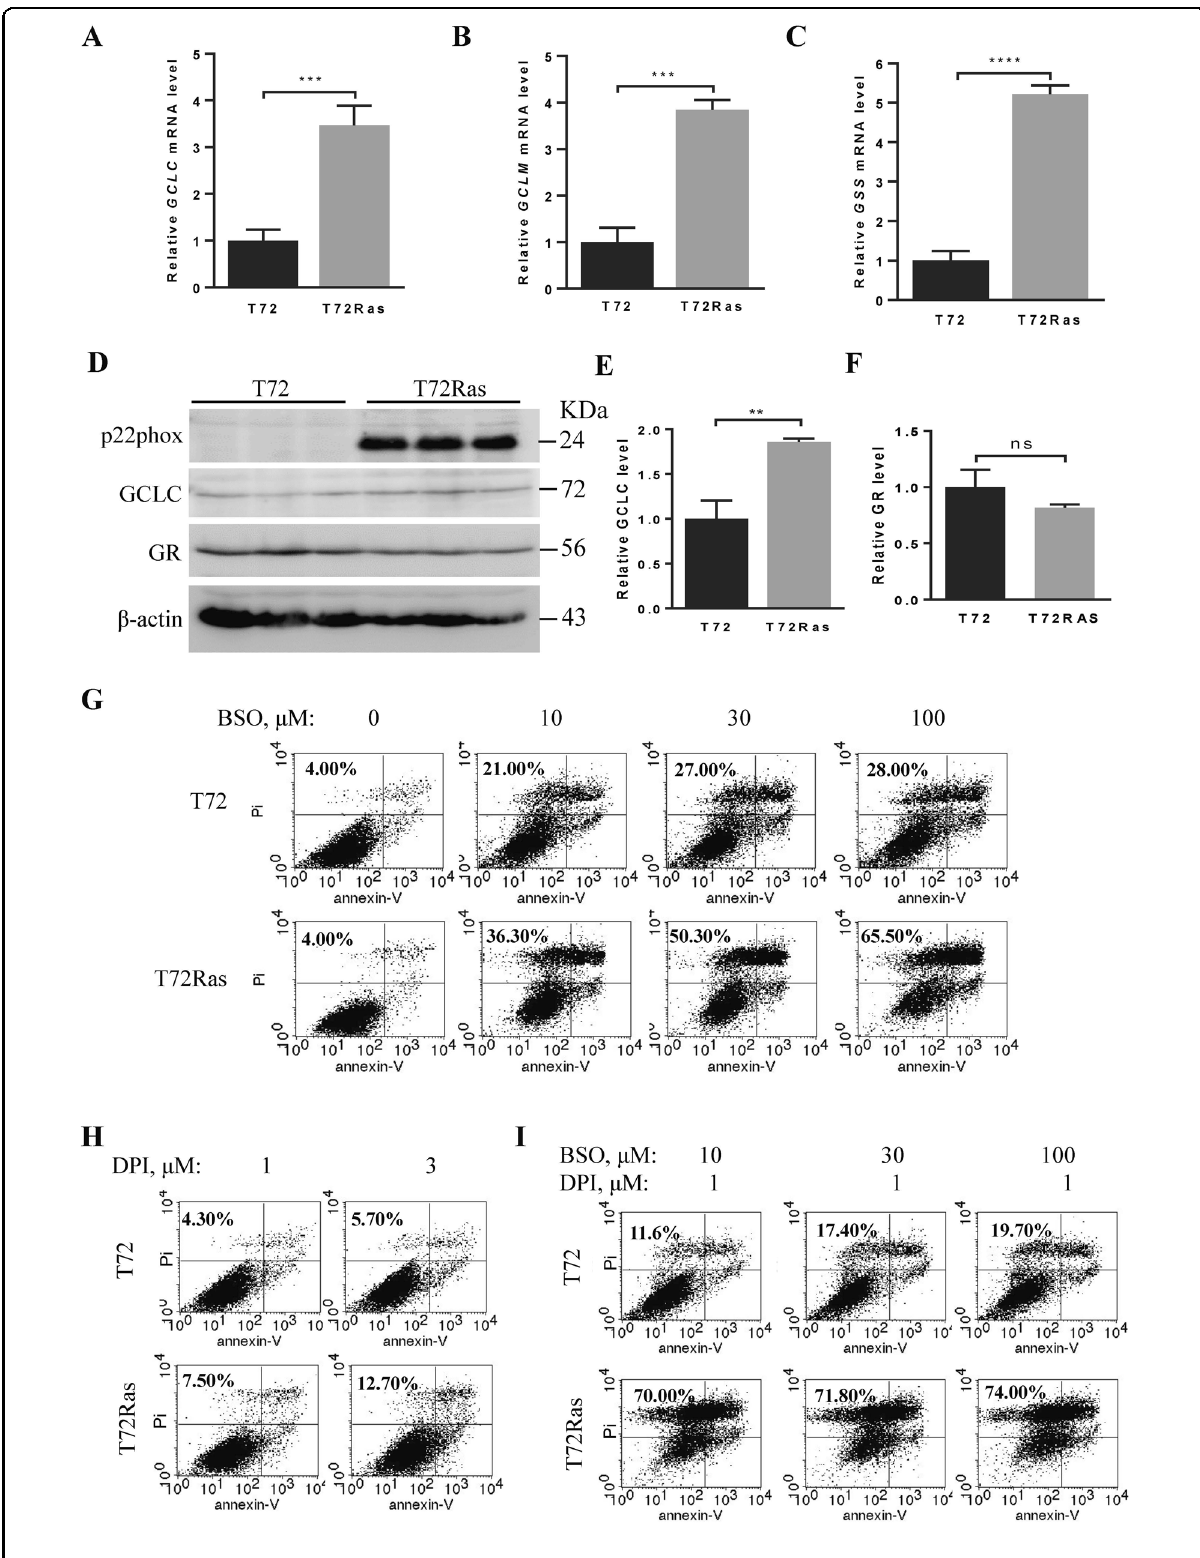
Fig. 1 (See legend on next